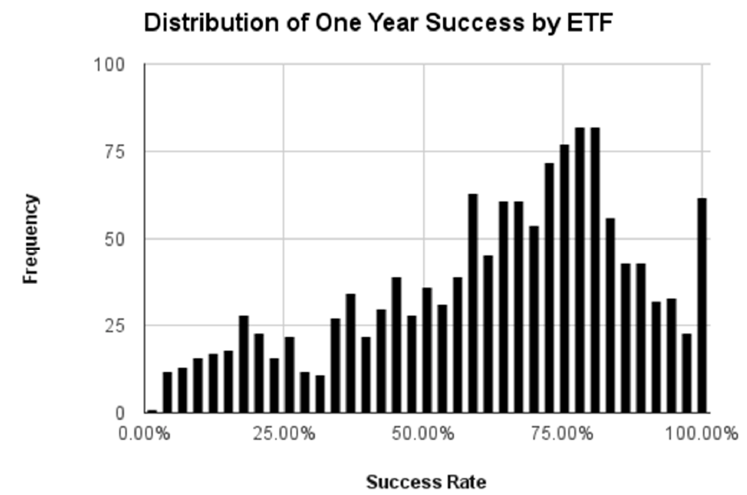
Figure 2. Distribution of One Year Success.